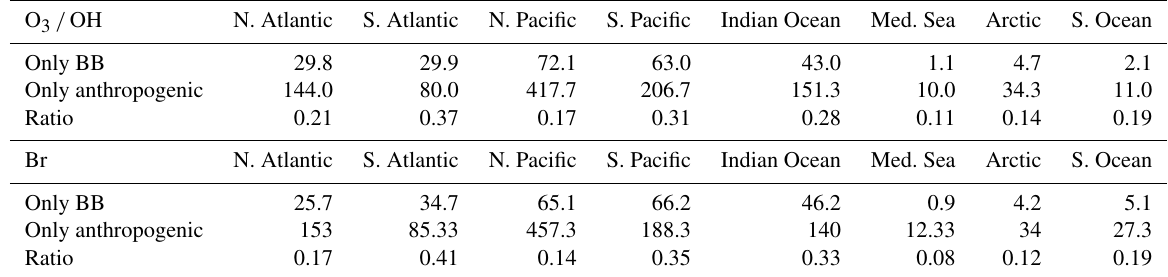
Table 5. Mercury deposition (Mg) to the oceans for 2013 from BB and comparison (ratio) with deposition from anthropogenic activities for both oxidation mechanisms. O 3 / OH N. Atlantic Only anthropogenic